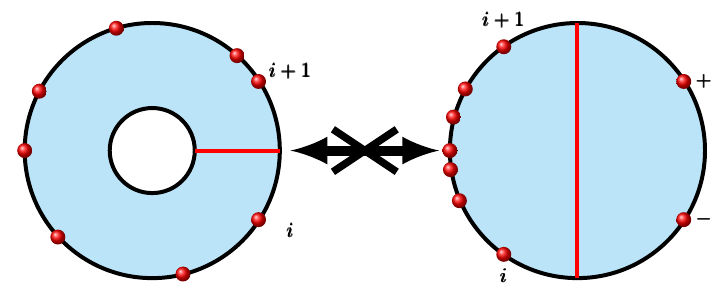
Figure 15 . These facets of and K 1 ;n and K n +2 are not